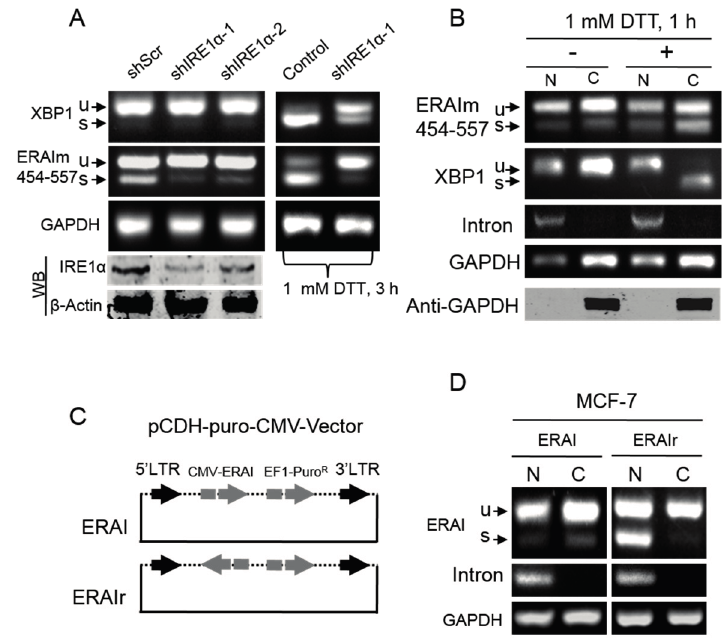
Figure 2. Acute ER stress-independent splicing of XBP1 mRNA sensor sequence in the nucleus. ( A ) IRE1 α knockdown in MCF-7/ERAIm454–557 cells by two shRNA